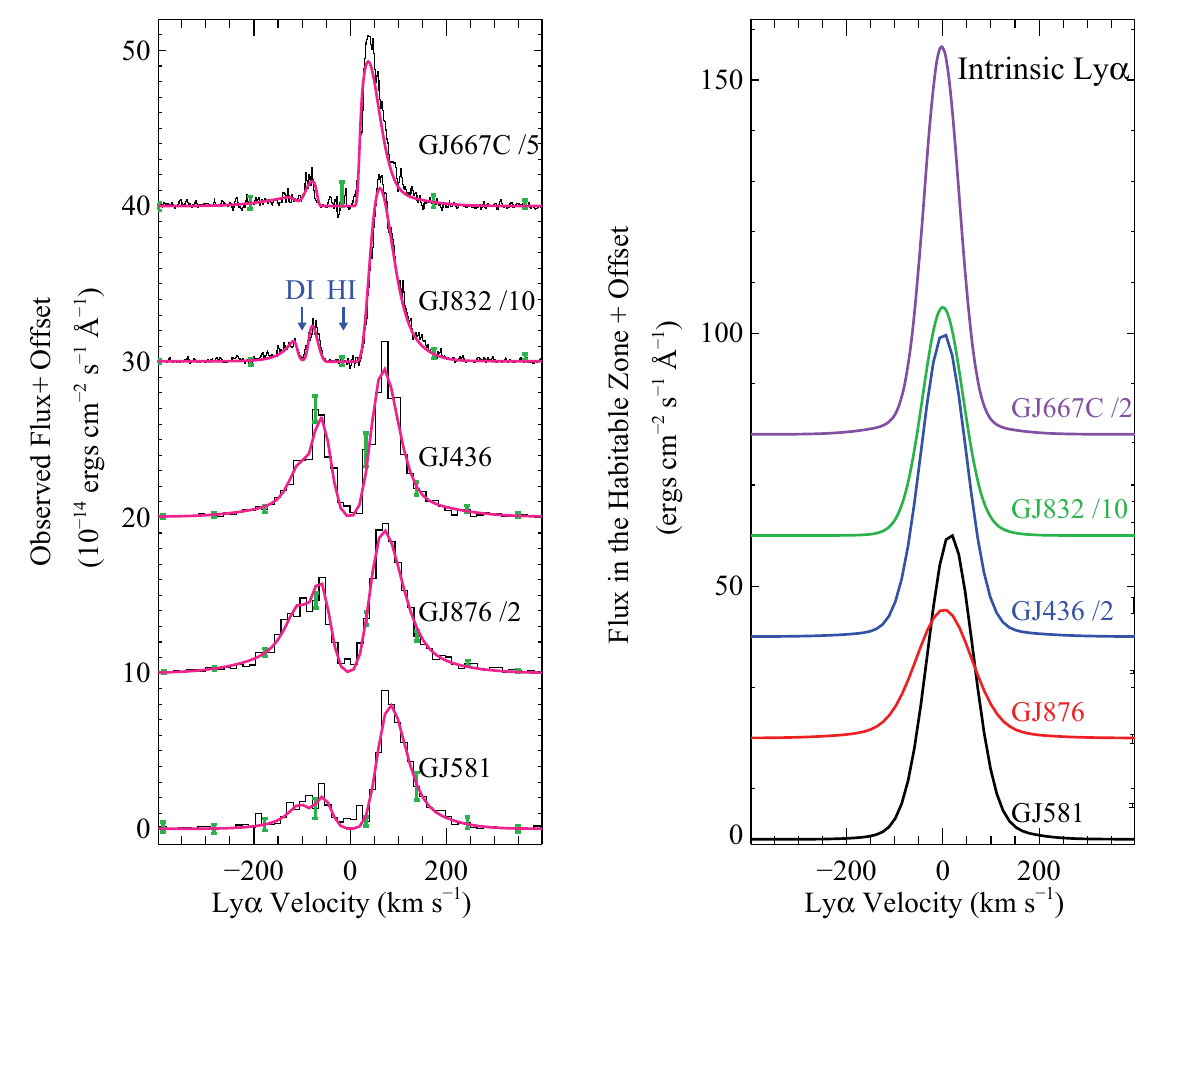
Figure 7. (Left Panel) Comparison of observed Lyman- α profiles (green histograms) of five M dwarf stars obtained by the HST/STIS instrument with computed profiles obtained using a best fit two-component Gaussian representation of the intrinsic stellar emission lines folded through the interstellar medium (red curves). The individual line profiles are offset by +20 erg cm − 2 s − 1 Å − 1 . (Right Panel) The best fit intrinsic Lyman- α line profiles for the five stars with the same offsets. Figure from France with copyright permission